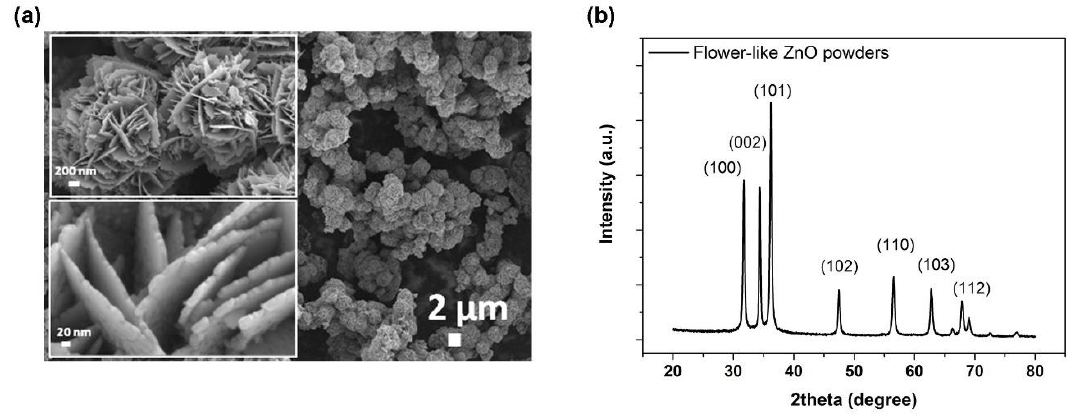
Figure 1. ( a ) FESEM images and ( b ) XRD pattern of flower-like ZnO microparticles obtained by hydrothermal method.